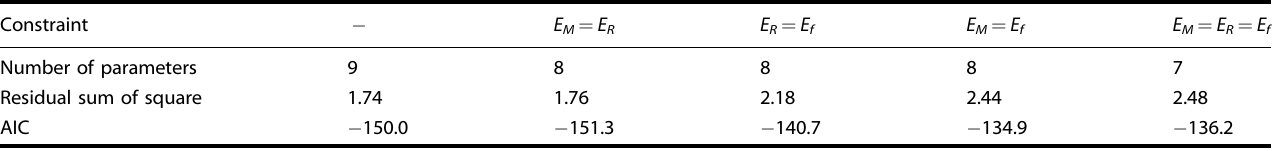
Table 1. Fit statistics for the coarse-grained resource allocation